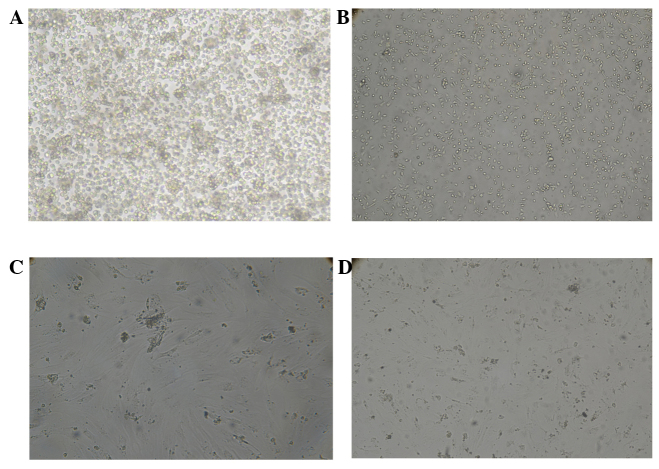
Primary New Zealand rabbit BMSCs were cultured with Dulbecco’s modified Eagles medium-F12 and images were captured at (A) 10 min and (B) 72 h following isolation (magnification, ×100). The third generation of rabbit BMSCs were cultured for 2 days and images were captured at magnification (C) ×100 and (D) ×400. BMSCs, bone marrow mesenchymal stem cells.